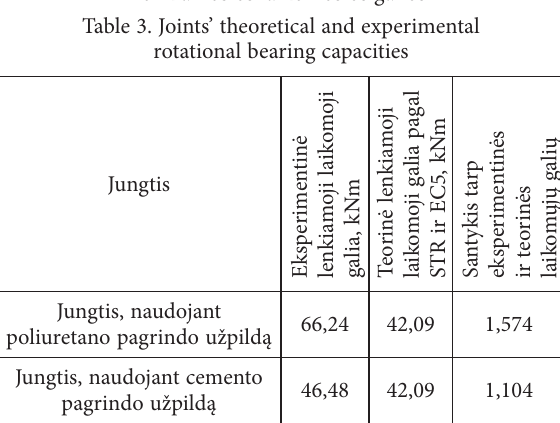
Table 3. Joints’ theoretical and experimental rotational bearing